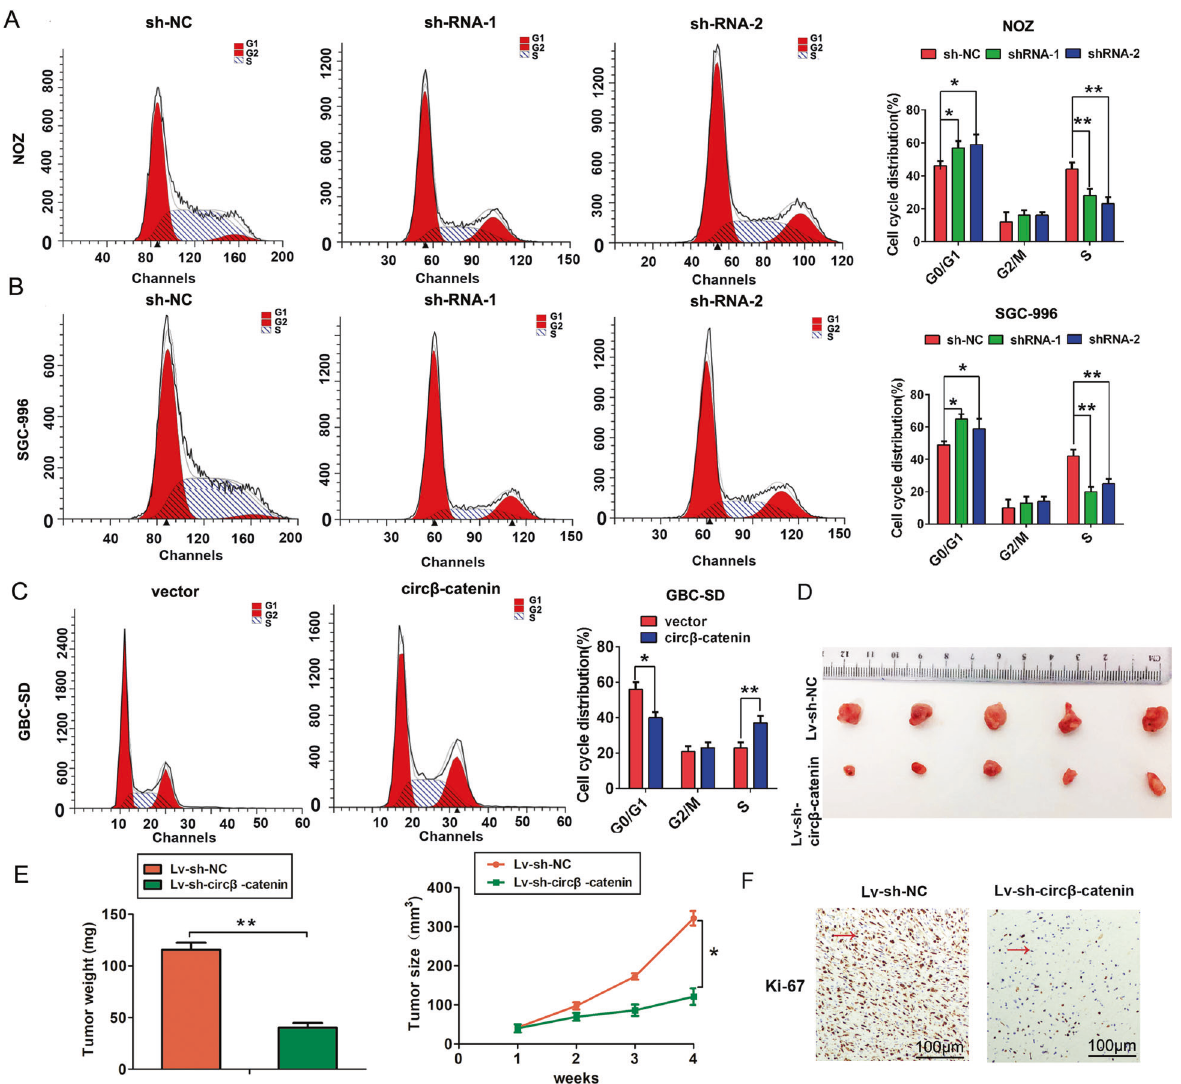
Fig. 3 The circ β -catenin promotes cell cycle progression in vitro and tumor growth in vivo. A , B Flow cytometry analysis was shown as the percentage cell phase distribution including G0/G1, S, and G2/M phases after transfection of NOZ and SGC-996 cells with shRNA-NC, shRNA-1, or shRNA-2. C Flow cytometry analysis was shown as the percentage cell phase distribution including G0/G1, S, and G2/M phases after transfection of GBC-SD cells with pLCDH-vector or pLCDH-circ β -catenin. D Nude mice were subcutaneously injected with Lv-shRNA-NC cells or cells transfected with Lv-sh-circ β -catenin, after 4 weeks, tumors were dissected and imaged. E Tumor weight or volume was detected to monitor tumor growth in subcutaneous implantation mouse models transfected with Lv-shRNA-NC cells or cells transfected with Lv-sh- circ β -catenin. F Immunohistochemical staining of Ki-67 expression was shown in tumor tissues in Lv-shRNA-NC or Lv-sh-circ β -catenin group (original magni fi cation, ×200). Data are shown as mean ± SD. * P < 0.05, ** P <